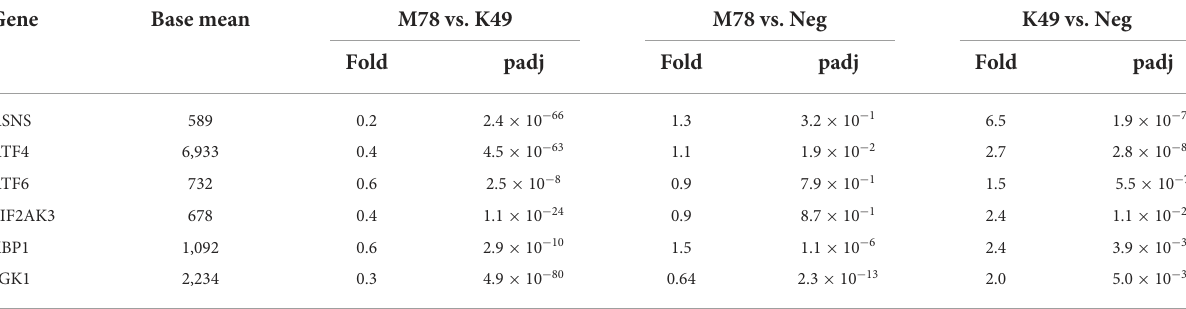
TABLE 8 Differential expression of genes involved in cellular stress response in PBMCs infected with ASFV strains K49 or M78 (FDR ≤ 0.05). Gene Base mean M78 vs. K49 M78 vs. Neg K49 vs. Neg Fold padj Fold padj Fold padj